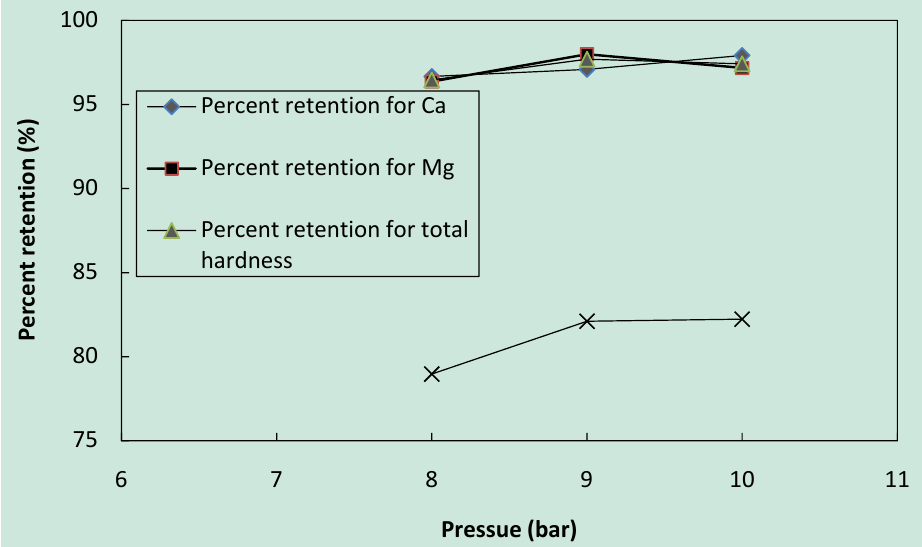
Figure 3. Retention of Ca 2+ , Mg 2+ , total hardness and TDS vs . pressure for Sample